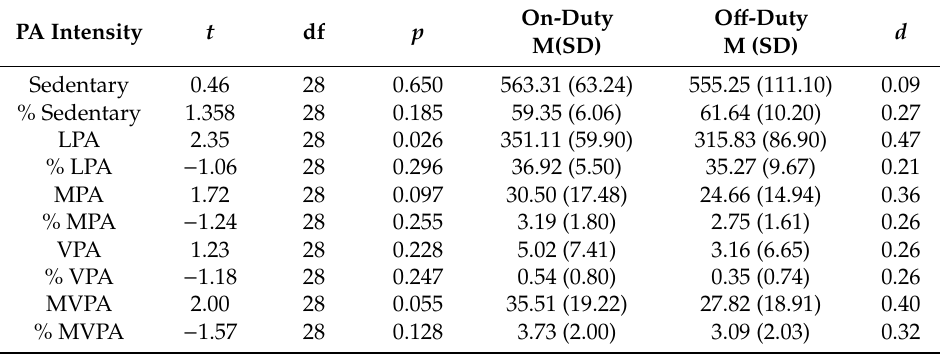
Table 1. Dependent t -test values and e ff ect sizes ( d ) for physical activity (PA) intensities.